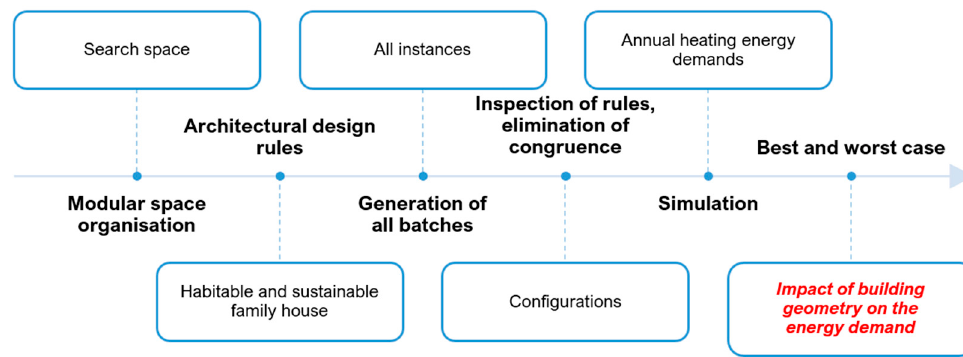
Figure 1. Process of configuration generation.